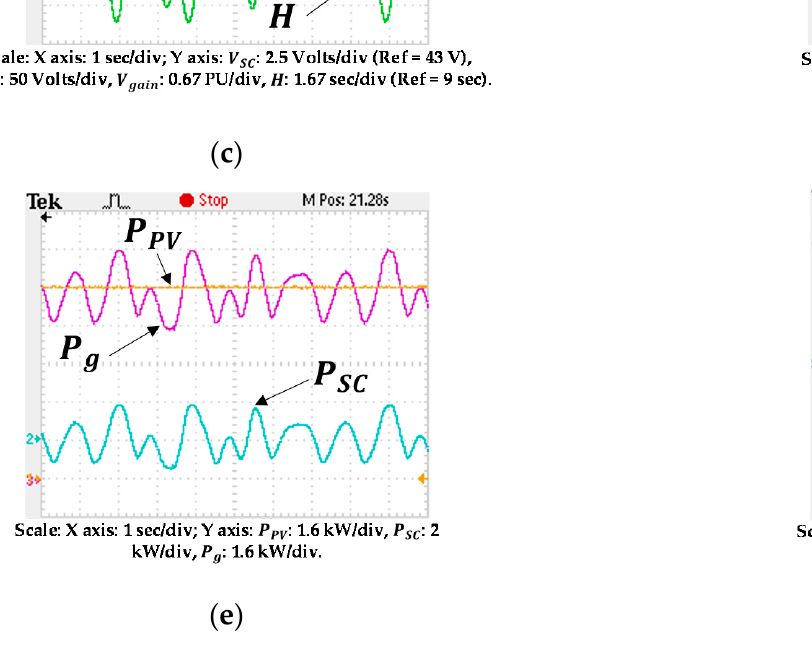
Figure 25. OPAL-RT RTS results for an example case of Low-Frequency Oscillation (Case 4 of Table 5): ( a ) frequency, RoCoF and Inertia constant profiles; ( b ) PV and SC currents subjected to variation in frequency; ( c ) variation in SC voltage, ZZB voltage and the Voltage gain of ZZB; ( d ) power profiles for the SC corresponding to RoCoF, Droop and their sum; ( e ) PV, SC and grid power profiles; ( f ) energy profiles for the SC corresponding to RoCoF, Droop and their sum.